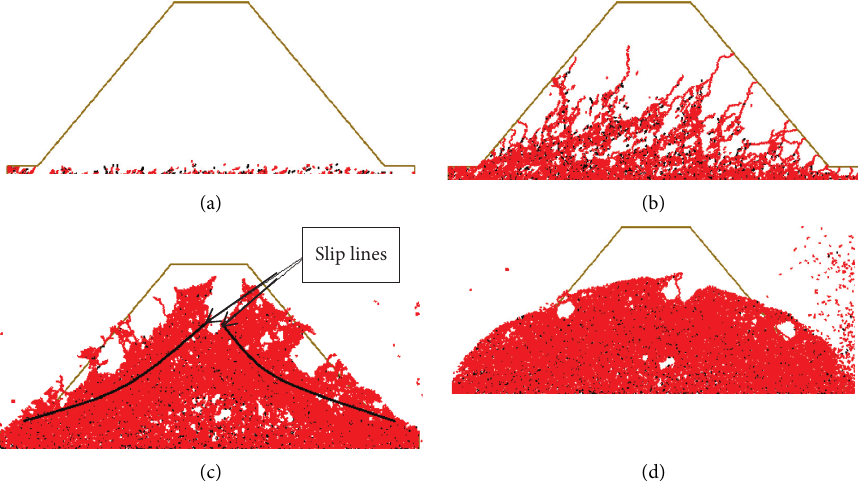
Figure 8: Crack development process with 8% moisture content. (a) At loading 0.1s. (b) At loading 0.5s. (c) At loading 1s. (d) At loading